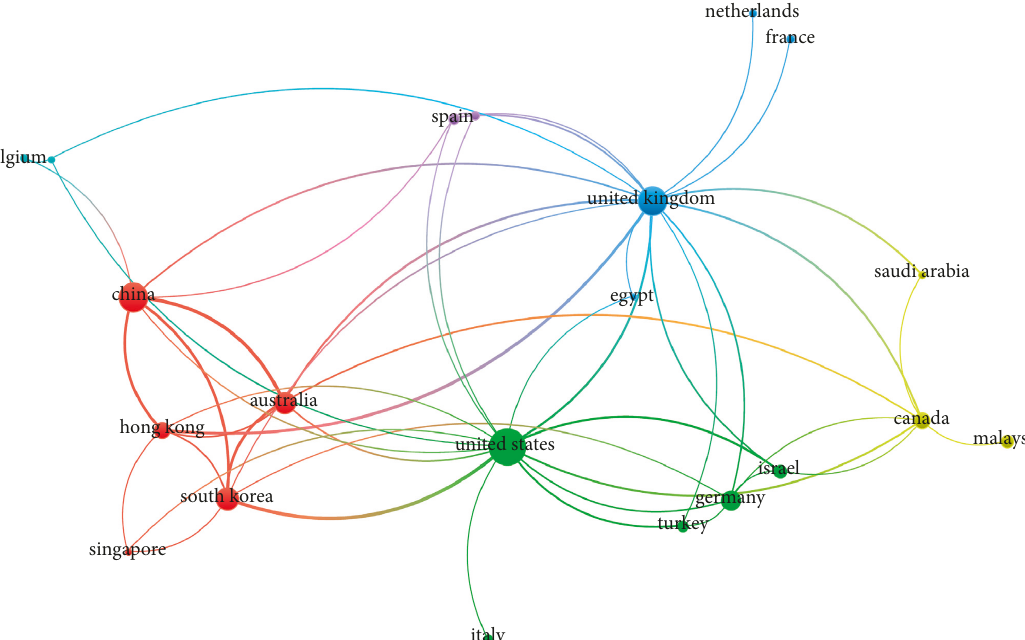
Figure 5: Coauthorship network of